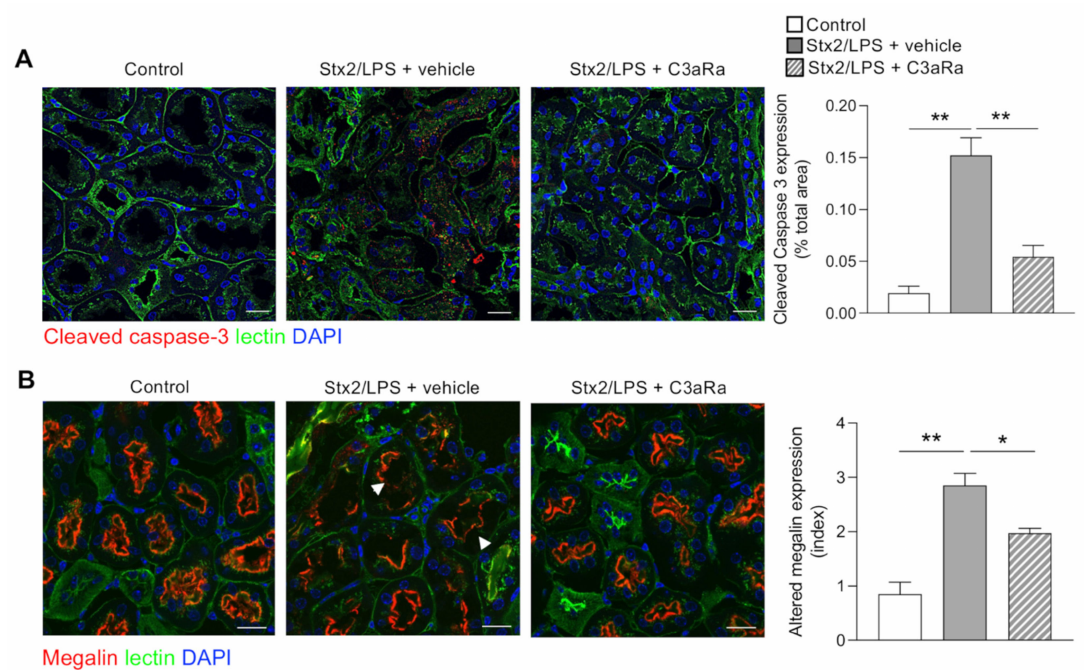
Figure 3. The C3aR blockade reduced proximal tubular cell apoptosis and restored megalin expression in Stx2/LPS mice. ( A , B ) Representative images and quantification of ( A ) cleaved caspase-3 (red) and ( B ) megalin (red) in control and Stx2/LPS mice given vehicle or C3aRa. Arrowheads indicate loss of megalin expression on the proximal tubular cell brush border. Cell membranes and nuclei were stained with FITC-WGA-lectin (green) and DAPI (blue), respectively. Scale bars: 20 µ m. Results are expressed as mean ± SEM ( n = 4 per each group), and ANOVA with Tukey multiple-comparisons test was used. * p < 0.05, ** p <